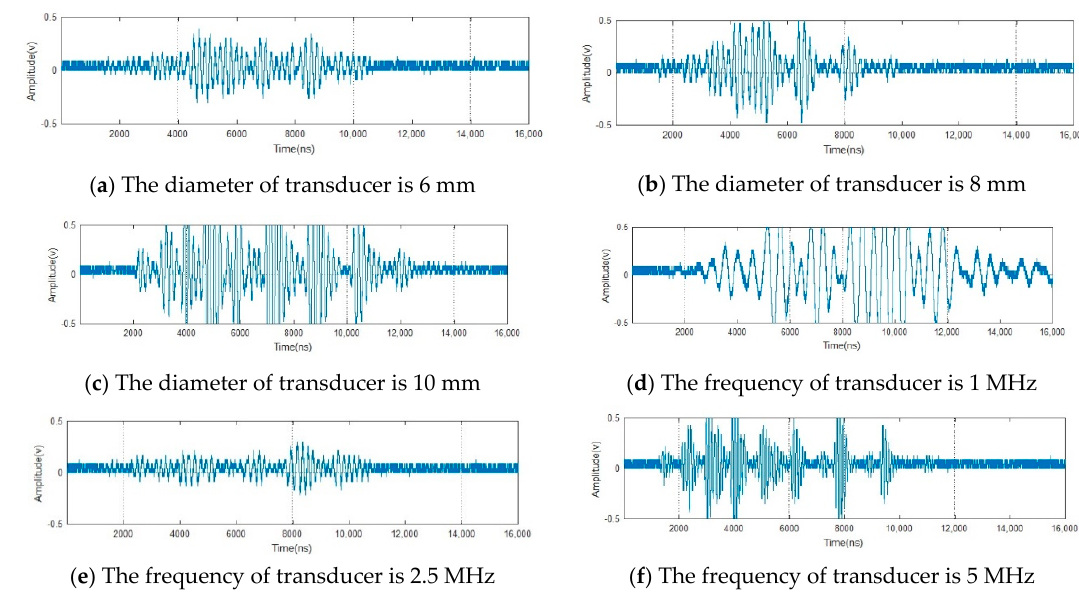
Figure 5. Received waves for various diameters and frequencies of the transducer.